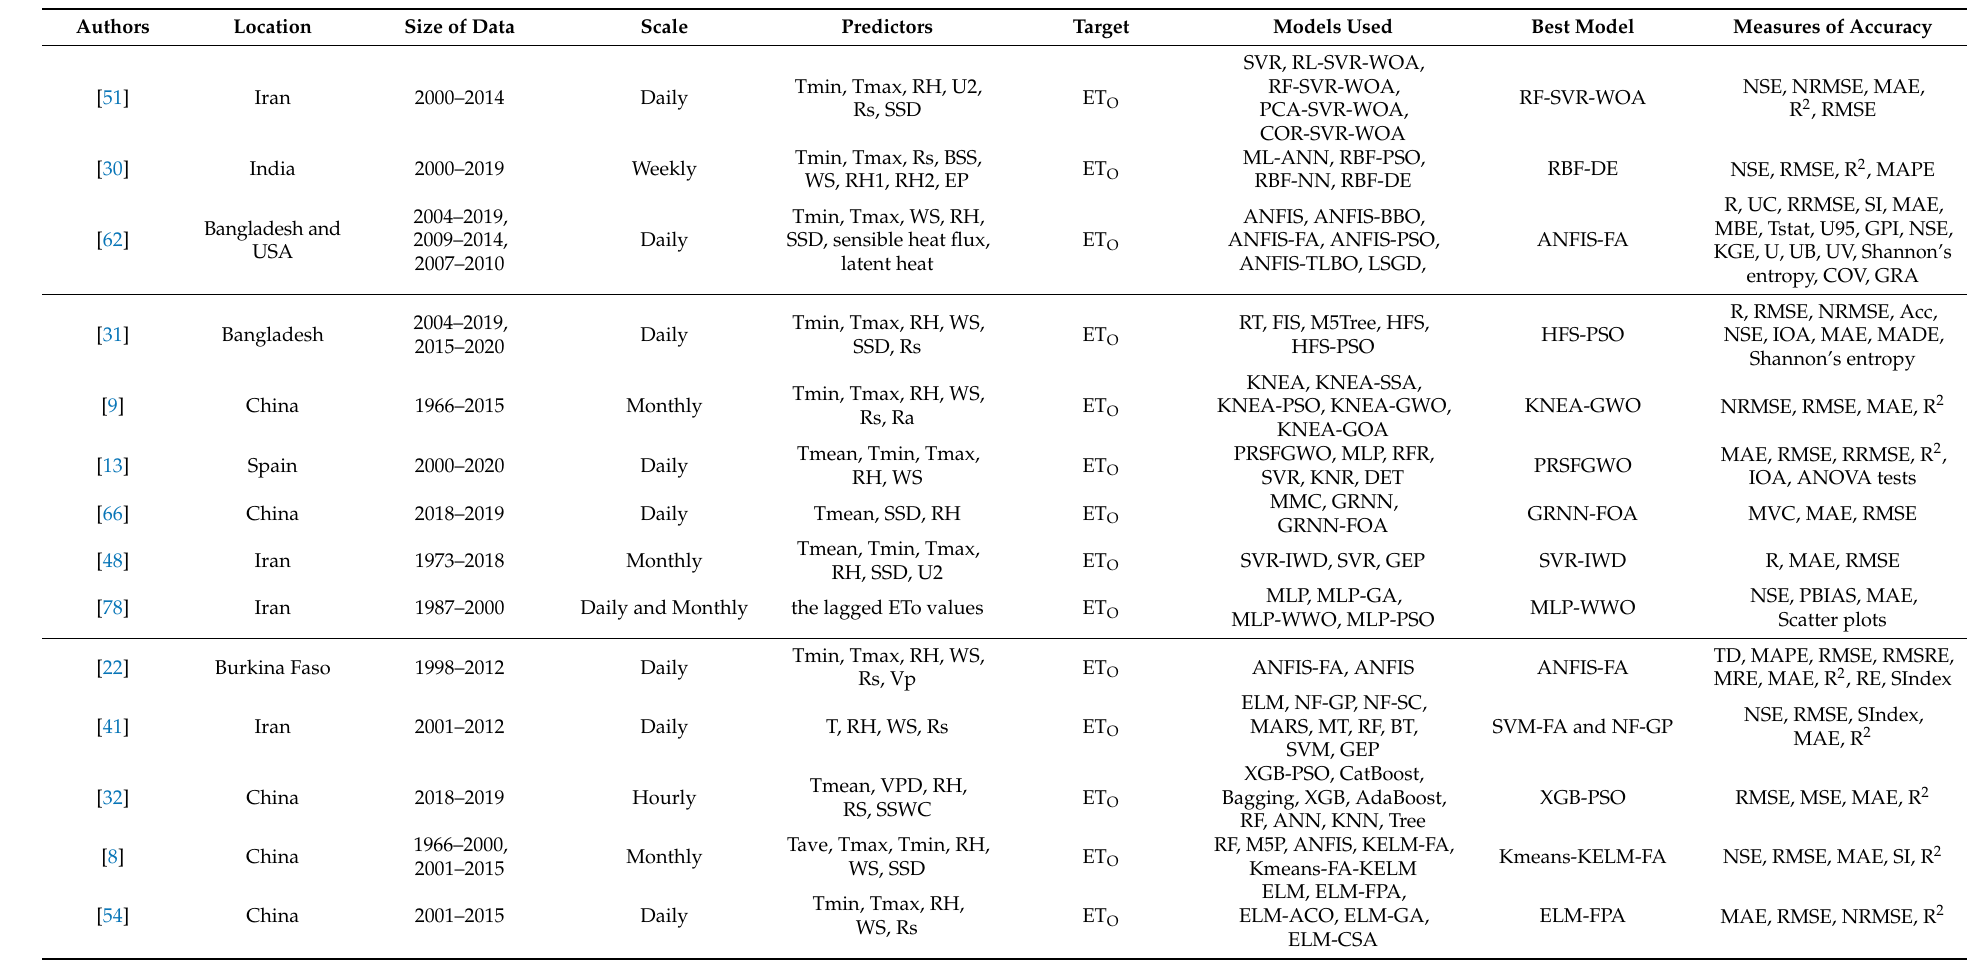
Table 1. Summary of application of various kinds of hybrid models in reference evapotranspiration